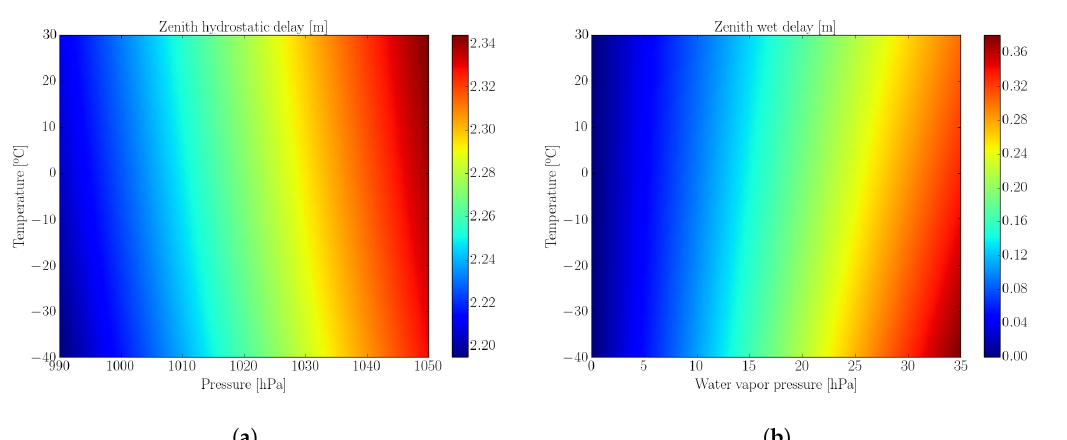
Figure 3. ( a ) Variation of ZHD with the pressure and temperature. ( b ) Variation of ZWD with the temperature and water vapor